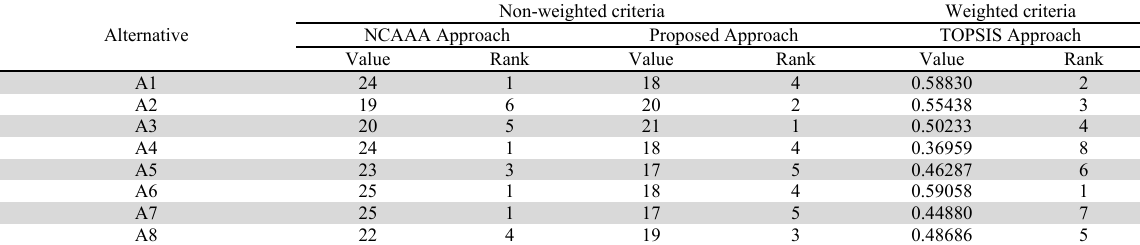
Comparative programs